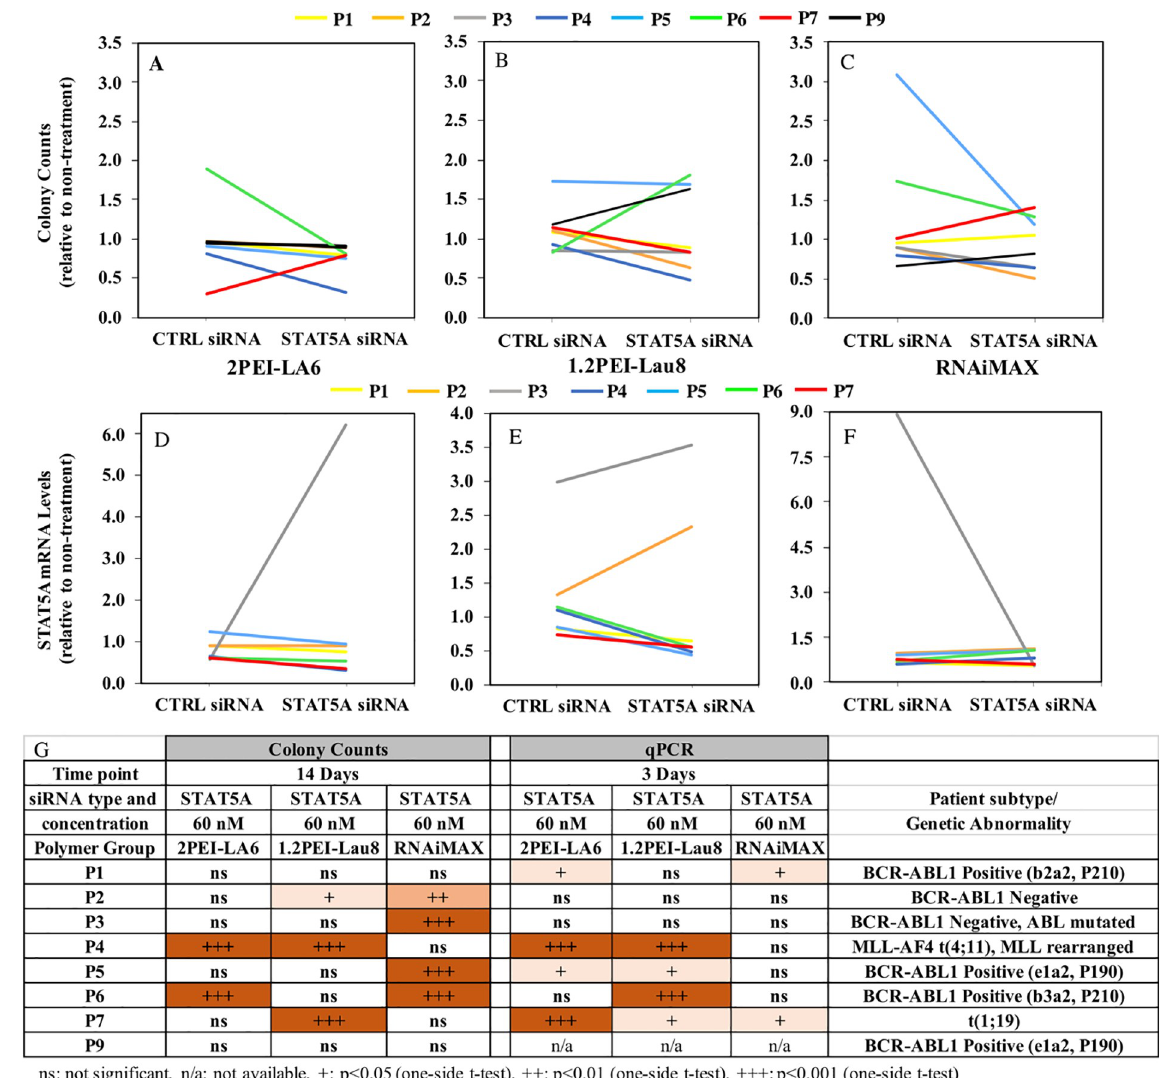
Fig 5. Effects of treatment with STAT5A siRNA/polymer complexes on colony formation (A, B and C) and STAT5A mRNA expression (D, E and F) in ALL primary cells. Colony counts were performed two weeks after transfection at a siRNA concentration of 60 nM and polymer: siRNA ratio of 6 and RNAiMAX:siRNA ratio of 2.5 for one day. STAT5A mRNA levels were assessed by qPCR after 3 days of transfection on frozen MN patient samples (n = 3). (G) Summary of statistical analysis for the results from qPCR and CFC assays.